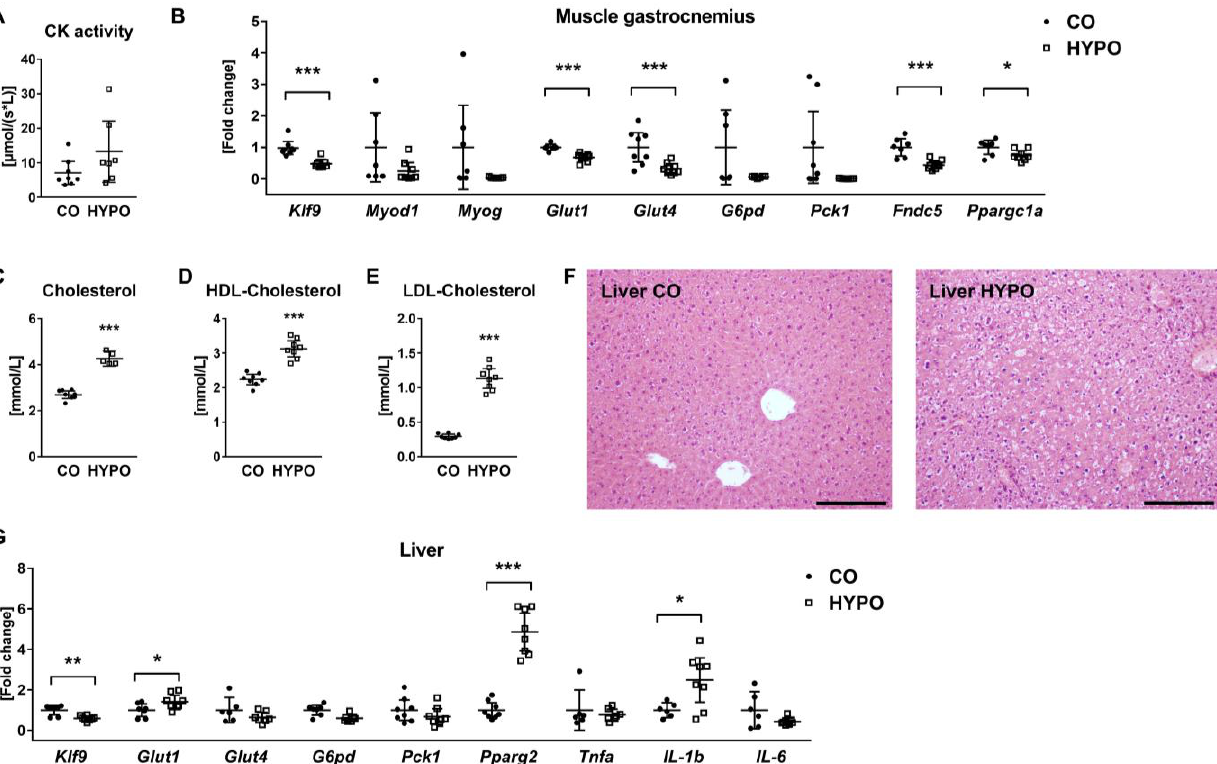
was calculated based on blood glucose levels over time. 2-[14C]-Deoxy-Glucose (2-14C-DG) uptake was tested in ( G ) tibia, ( H ) muscle, ( I ) epididymal WAT (eWAT), and ( J ) liver of hypothyroid vs. control mice. Each dot indicates an individual mouse. The horizontal lines represent the mean ± 95% CI. Body weight curves, fasting blood glucose, and ipGTT: CO: N = 13, HYPO: N = 10; ipITT: CO: N